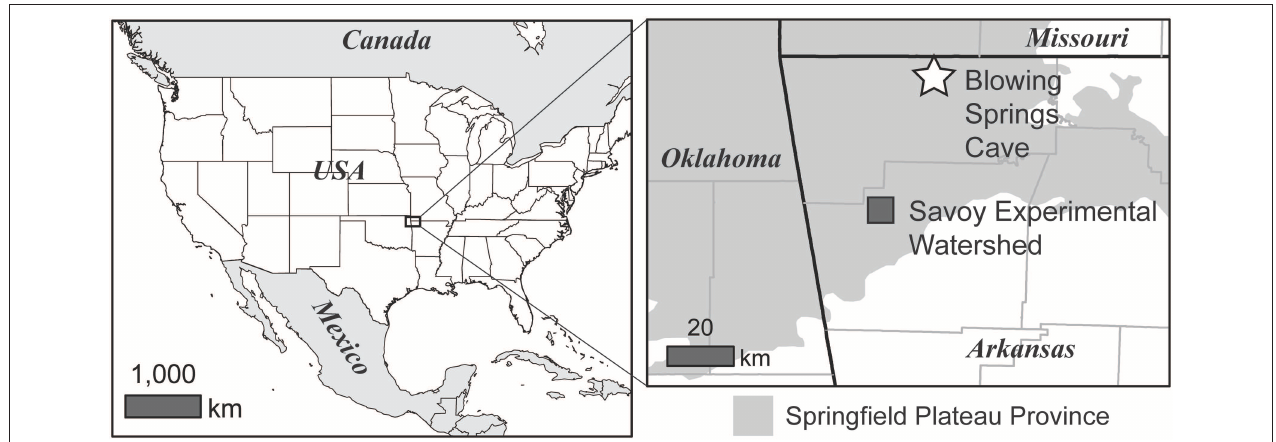
Savoy Experimental